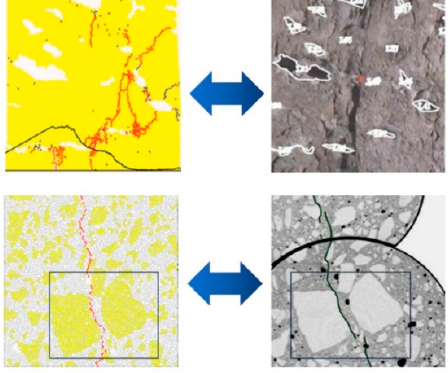
(clusters) and the boundary is specified in the contact model, which is used to calculate the relative motion and the load transfer between the particles (clusters) [39].